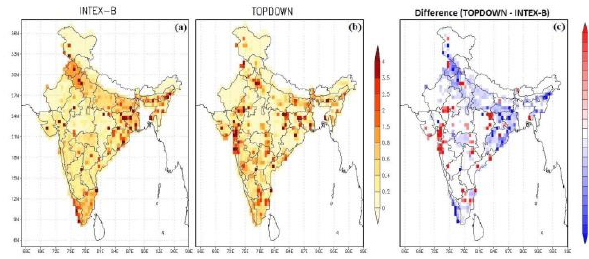
Fig. 5. Satellite constraints of NO x emissions in India [8]